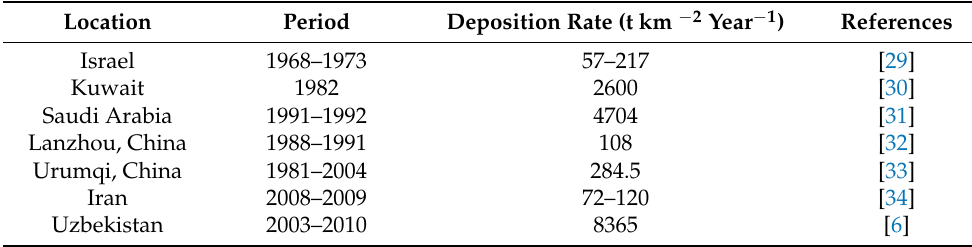
Table 1. Observation of dust